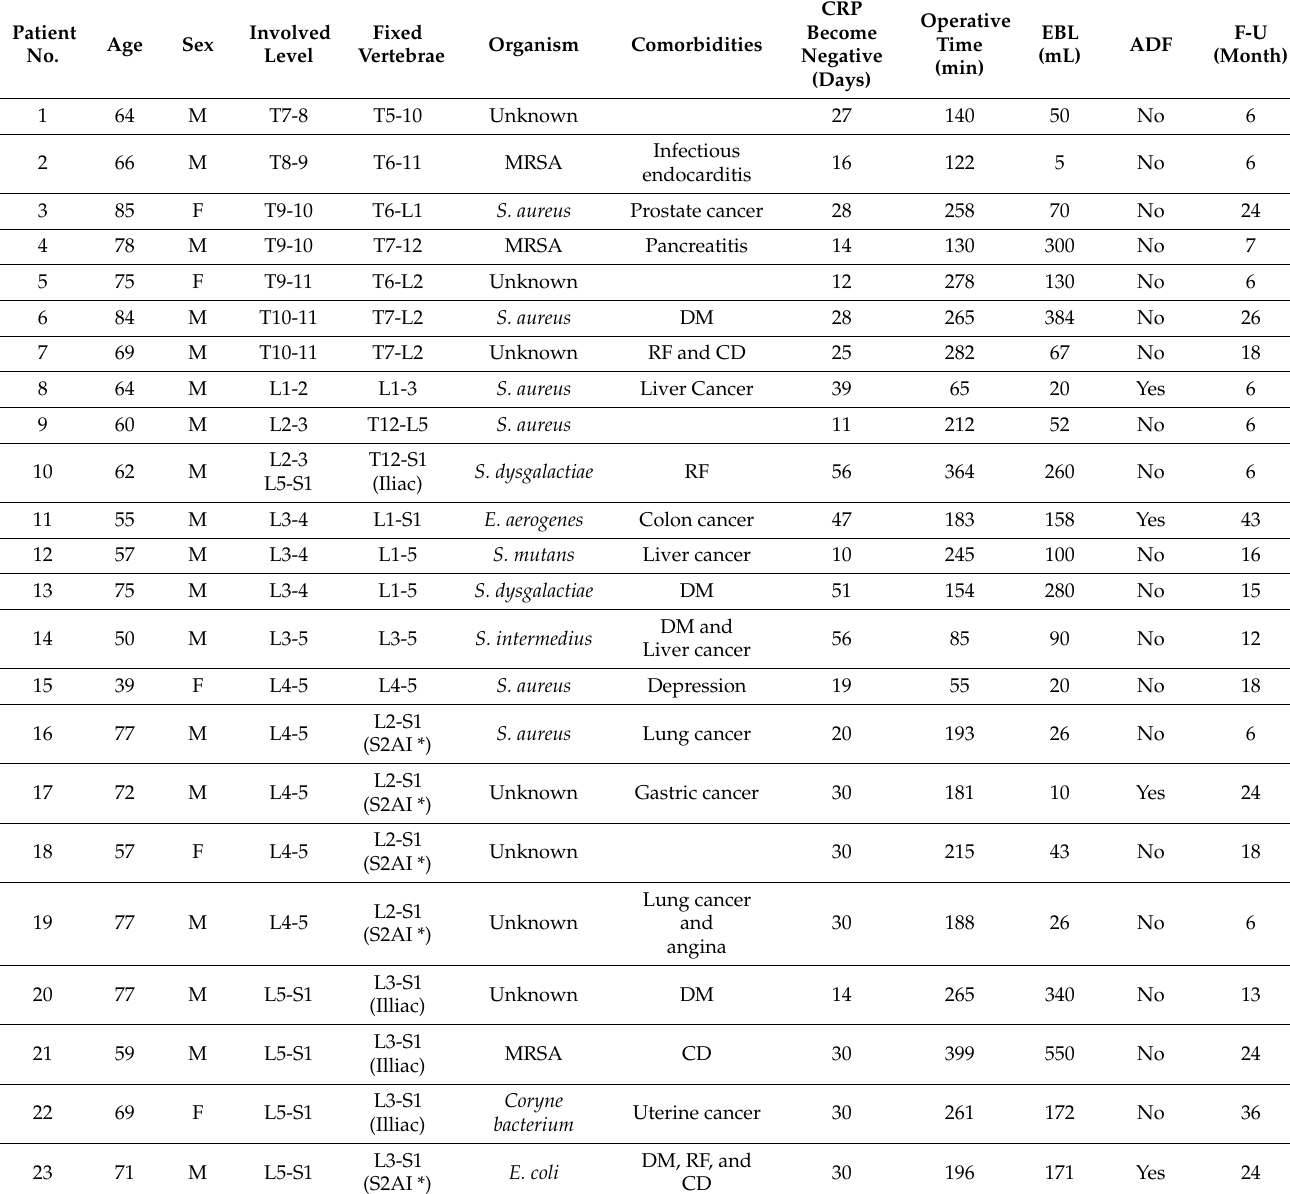
Table 3. Detailed presentation of patient data.